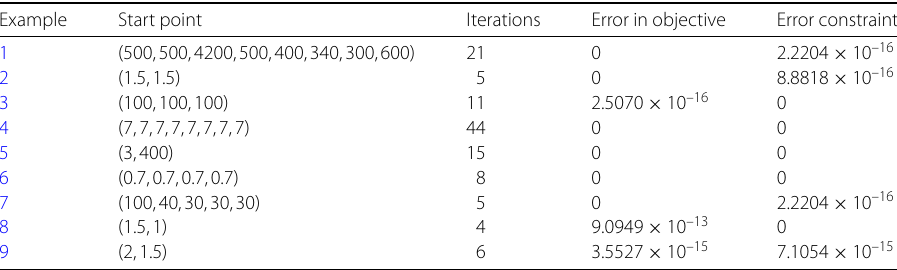
Table 1 Results of Examples 1–9 obtained by utilizing the presented method